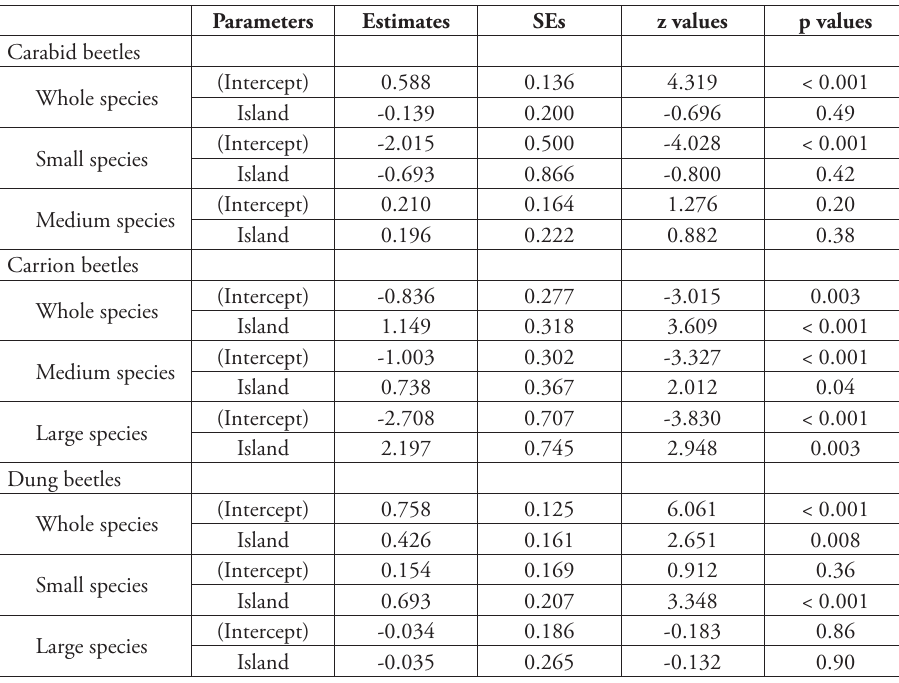
Table 2. Estimates of parameter differences between sites (reference = lakeshore site, i.e., coefficients of lakeshore site are zero), standard errors (SEs), z values, and p values in generalized linear models of each of taxonomic group and body size group species richness. Bold letters represent p < 0.05.